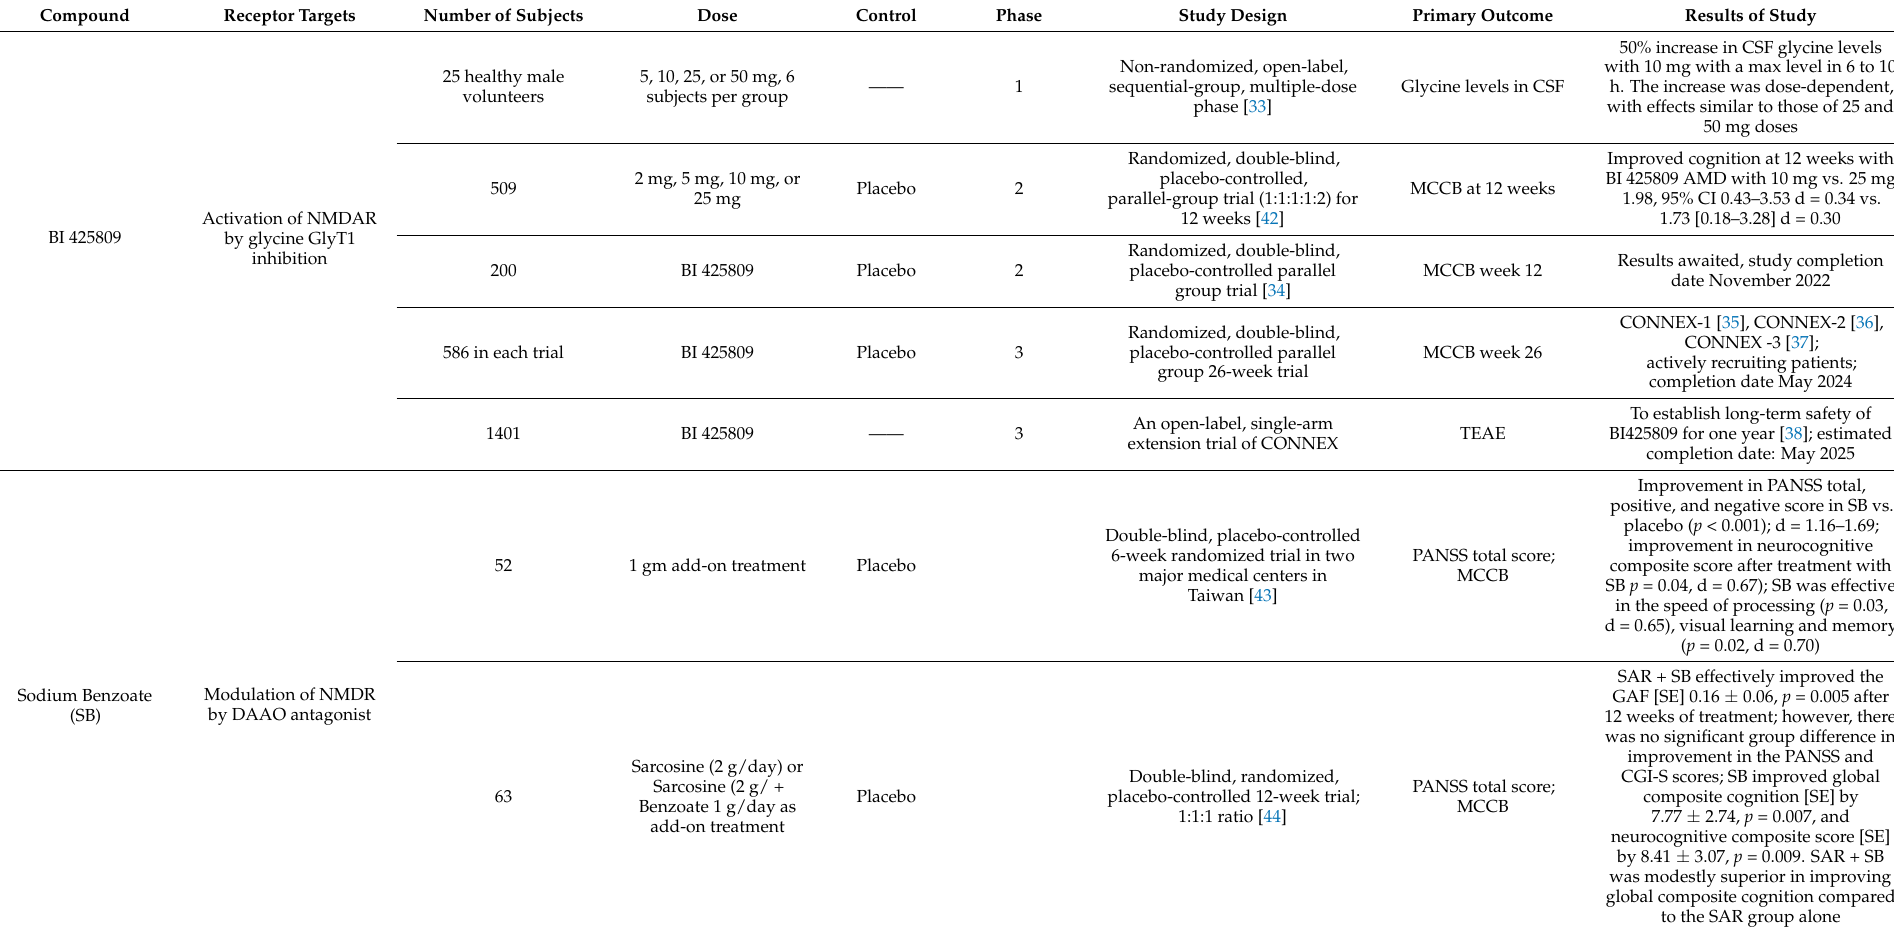
Table 4. Modulators of Glutamatergic